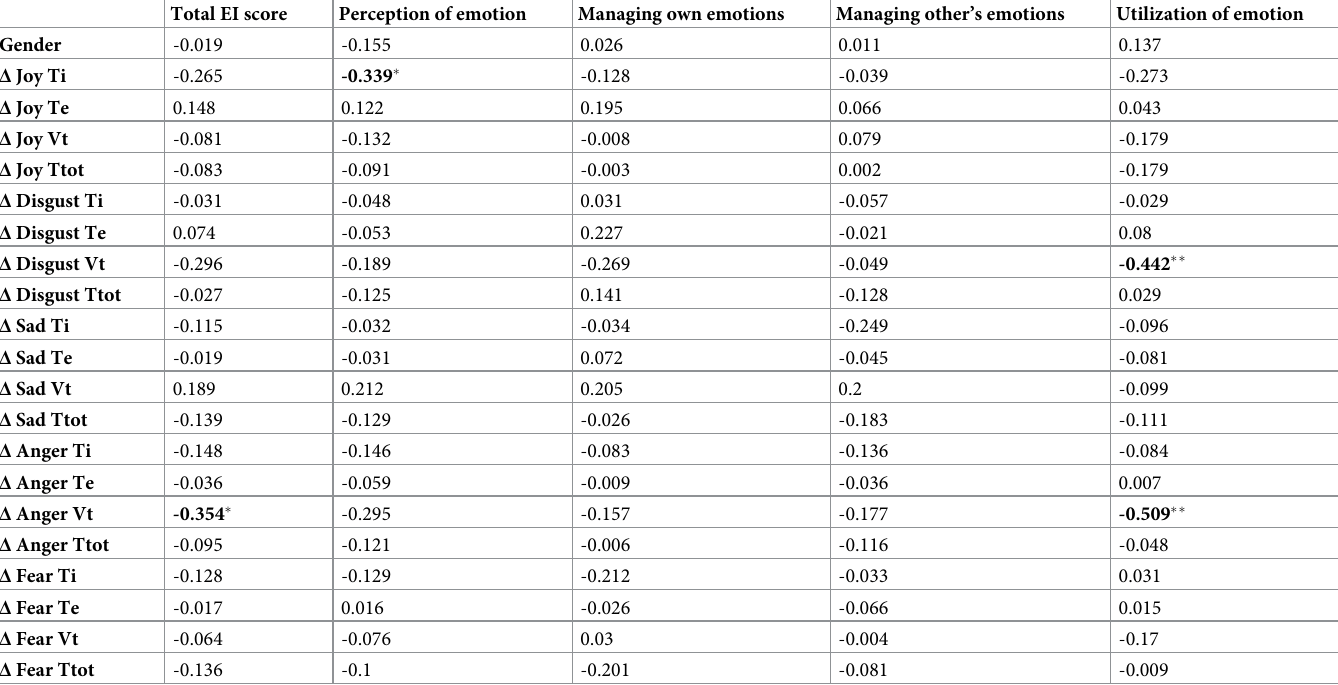
Table 13. Pearson correlation between cardiac reactivity parameters and Emotional Intelligence scores.